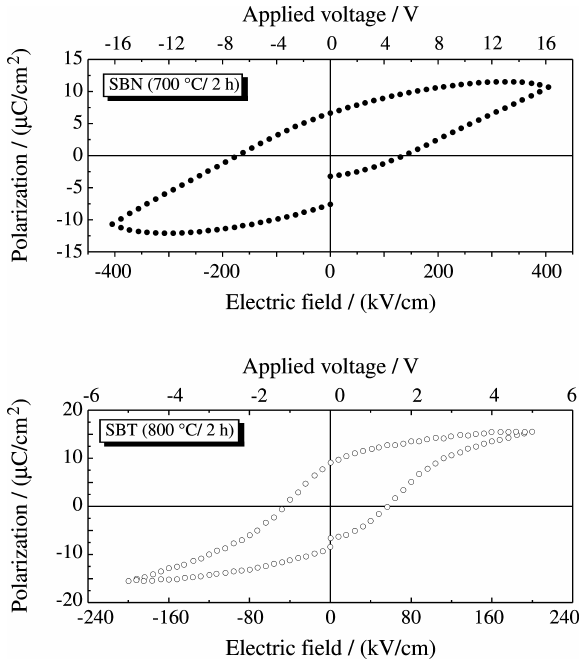
Figure 7. Hysteresis loops ( P-E ) of the SBN and SBT films.